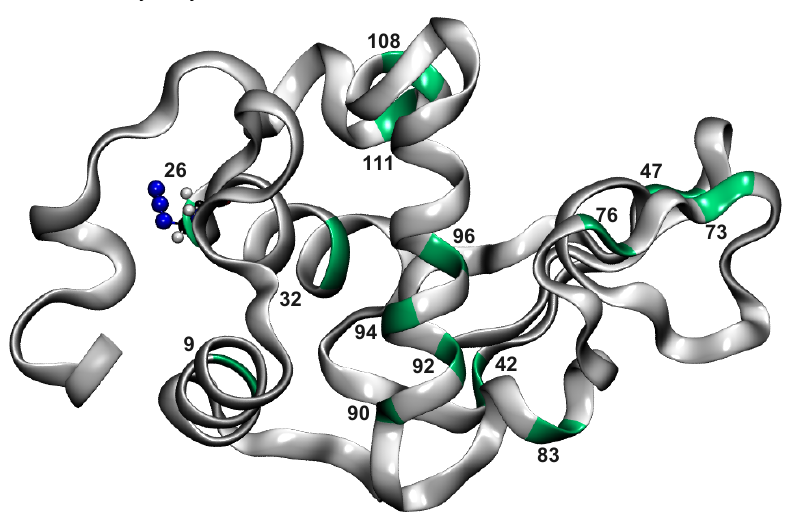
Figure 1. Lysozyme structure with N 3 -labelled alanine residues at positions 9, 26, 32, 42, 47, 73, 76, 83, 90, 92, 94, 96, 108, and 111. Ala residues are indicated in green, while the rest of the protein structure is shown in grey. Ala26N 3 is shown in CPK as an example of an alanine modified residue. First, the system is minimized followed by heating and equilibration for 100